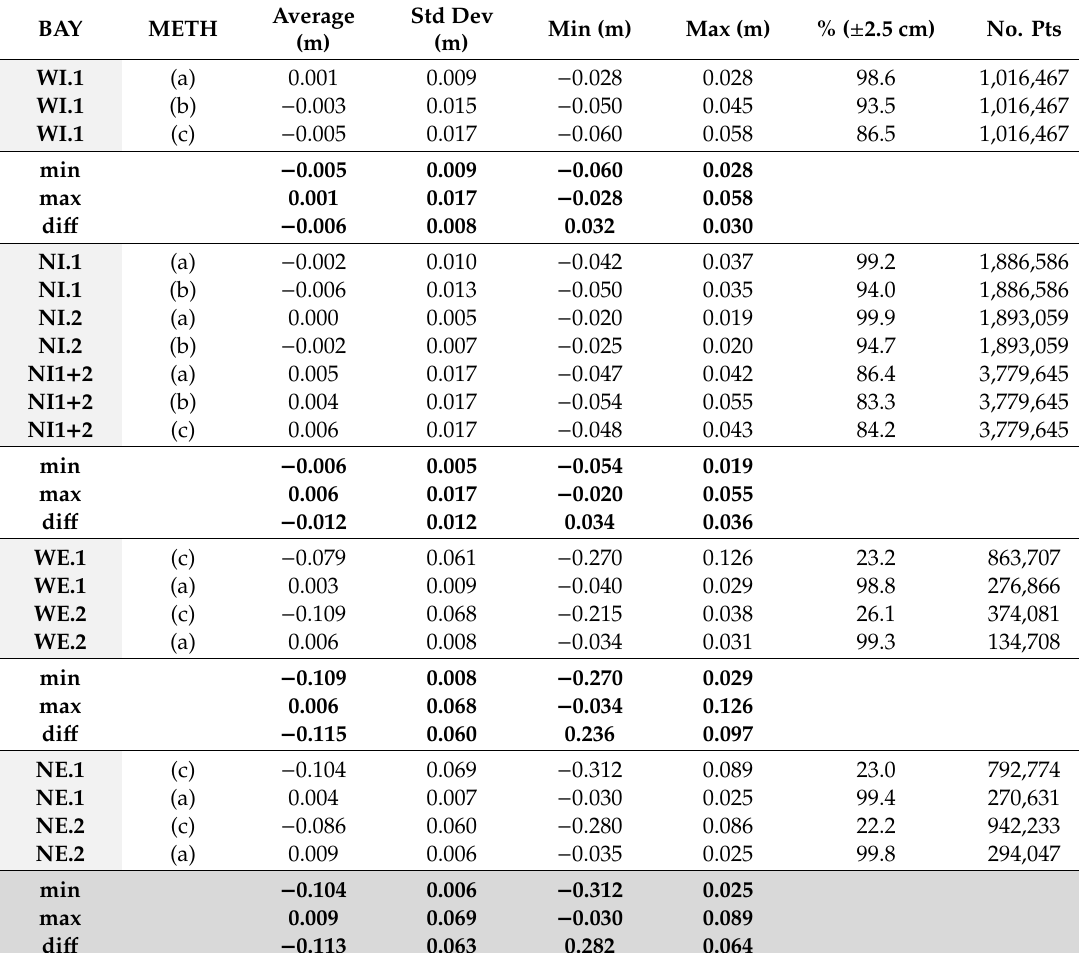
Table 2. Comparison between reference planes and the walls point